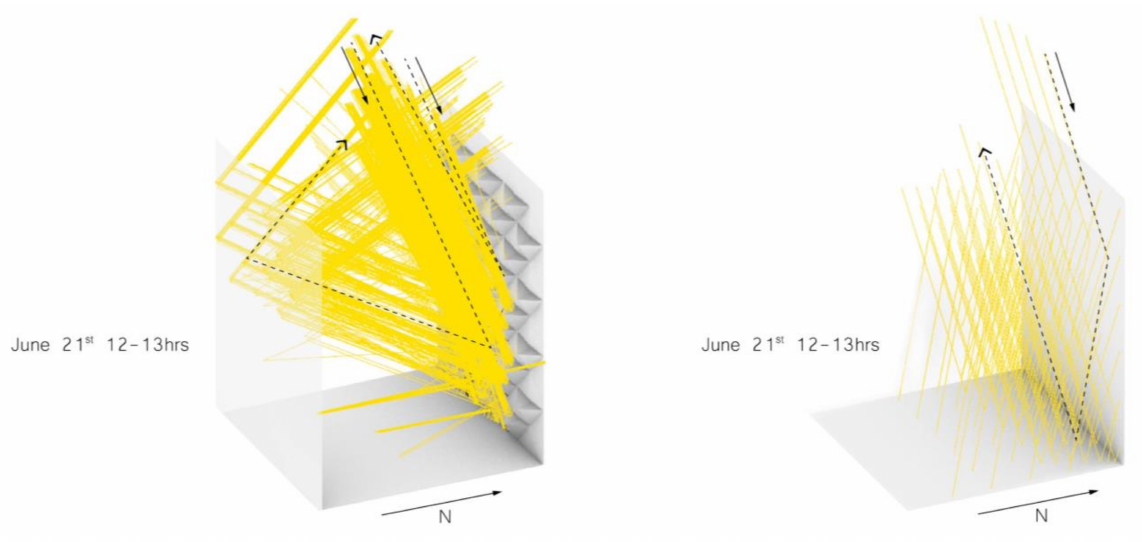
Figure 19. Comparative sun ray trace analyses of the proposed façade (left) and a typical façade in an urban street canyon, including the reflection towards the opposite building.